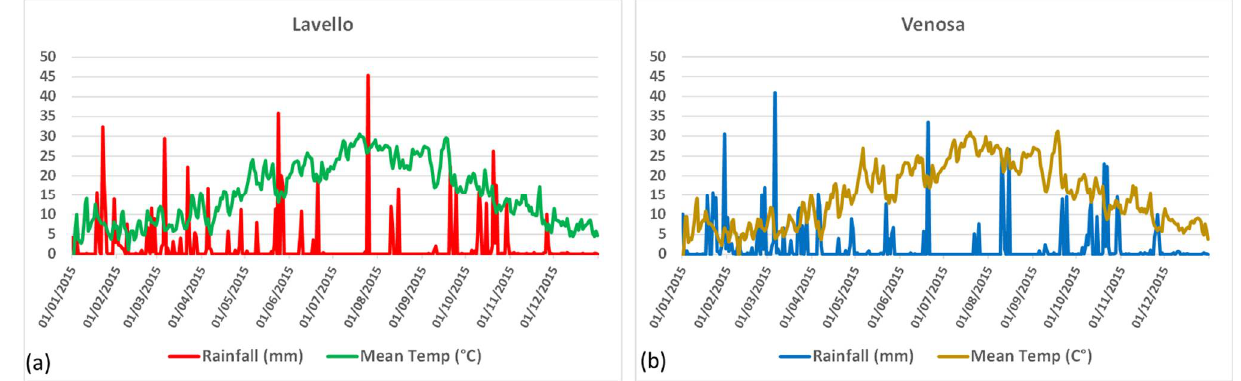
Figure 2. Daily data of rainfall (mm) and mean air temperature (°C) recorded for the year 2015 at the weather stations of ( a ) Lavello (location of DV study site) and ( b ) Venosa (location of CA study site) (source: ALSIA network of Basilicata).